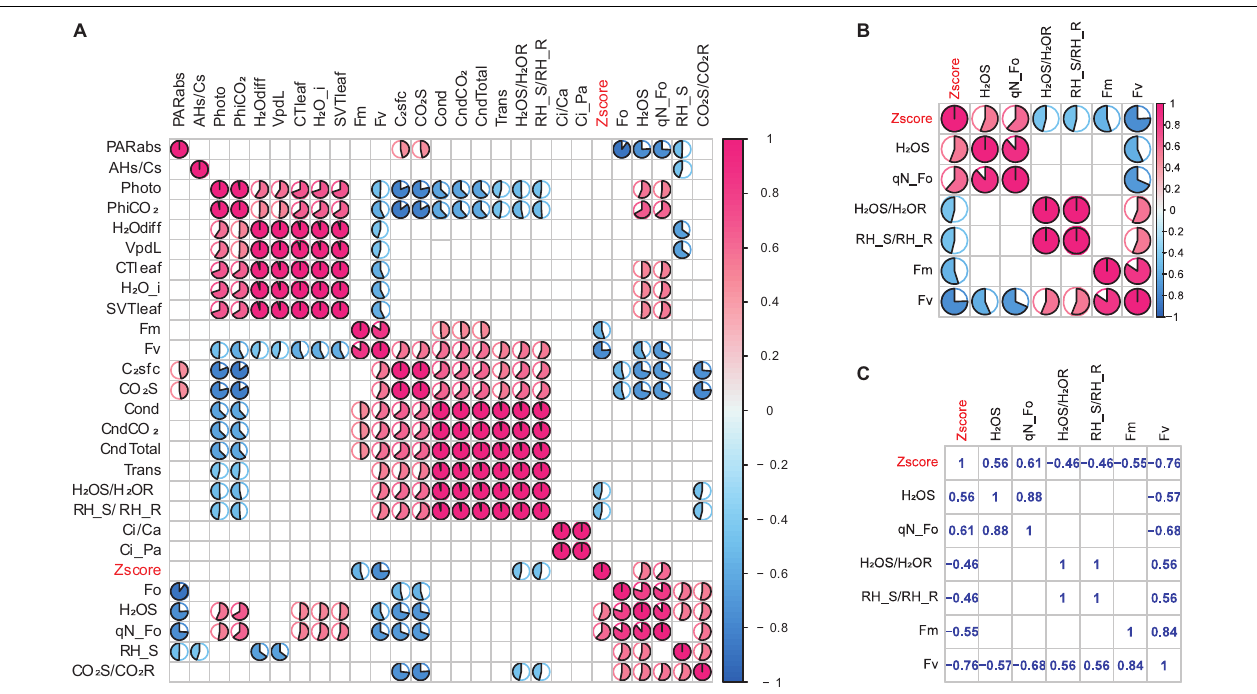
FIGURE 3 | Heat map of Pearson’s correlation coefficient. (A) Heat map of 26 features. (B) Heat map of 6 features. (C) Specific values of 6 features.